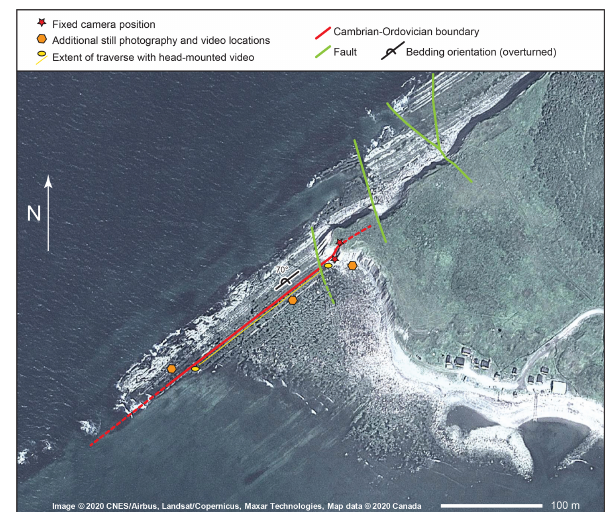
Figure 5. Satellite view of Green Point stratotype area showing the location of the installation and recording locations. Imagery: © 2020 CNES/Airbus, Landsat/Copernicus, and Maxar Technolo- gies. Map data: © 2020